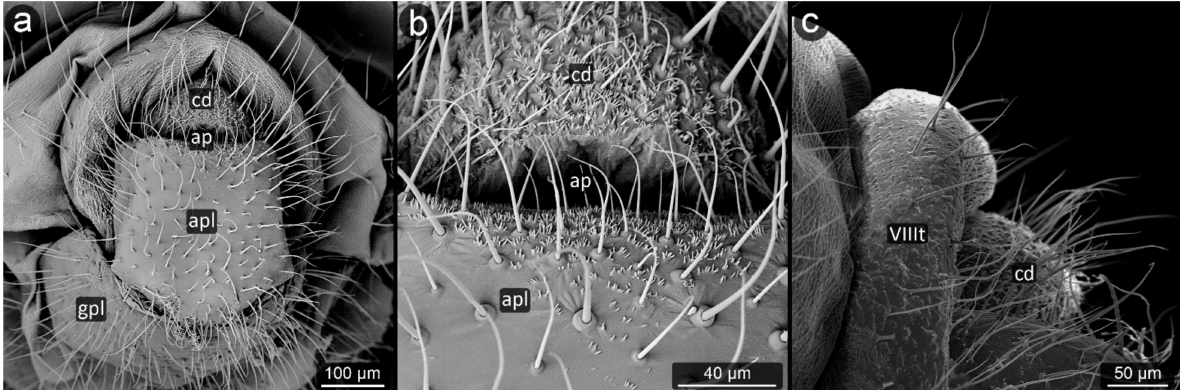
Figure 19. Perianal structure of Lachnus pallipes in SEM; ( a )—rear view, ( b )—close-up on the surface of cauda and anal plate, ( c )—lateral view. Abdominal tergite VIII: the last segment of the abdomen with a smooth surface, cov- ered with approximately 30 pointed